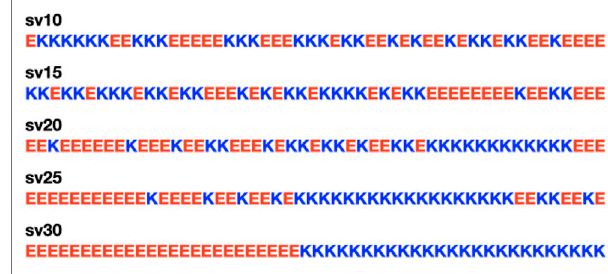
FIGURE1| The fi ve(Glu-Lys) 25 IDPsequencevariantsusedinthestudy. Glutamic acid (E) iscolored in red for negative charge, and lysine (K) iscolored in blue for positive charge. The labels for the sequence variants (sv) are from Das and Pappu (2013). The fi ve sequence variants are the same ones tested in McCarty et al.